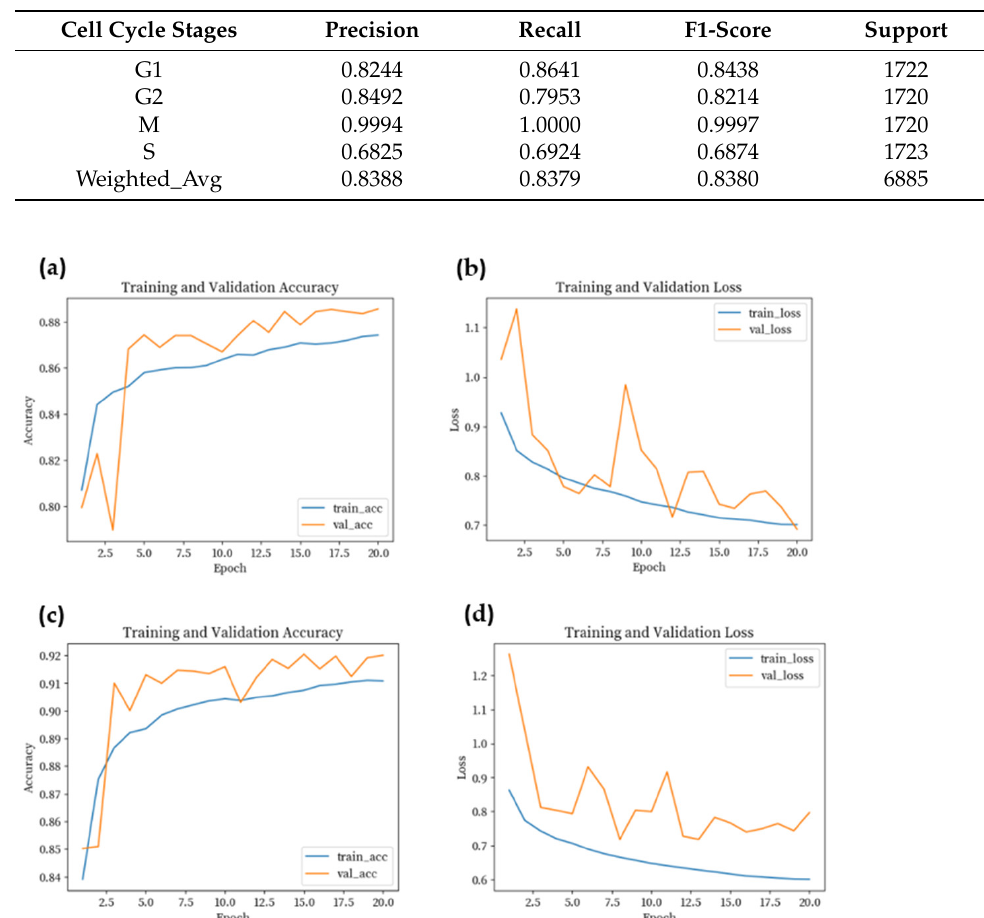
Figure 8. The ROC curves of classification. ( a ) Four-stage classification of original images; ( b ) four- stage classification of generated images. 4.3. Verification of Results with New Dataset In order to verify the effectiveness of our model, another cell cycle data set was used. Nagao et al. [13] collected fluorescence microscope images of different cell cycles contain- ing subcellular structures, such as the nucleus, the Golgi apparatus, and the microtubule cytoskeleton (HeLa dataset). The classification of different cycle stages could be carried out by extracting the characteristics of these subcellular structures. The data set contained only two categories, namely G2 and non-G2. The cell cycle images of the G2 phase were regarded as one class, and the images of the G1 phase and the S phase were regarded as one class. The images of the M phase were not in this data set. The numbers of images in the G2 class and the non-G2 class were each 922. The original images of the G2 class and the non-G2 class are shown in Figure 9. The WGAN-GP was used to generate images for the G2 class and the non-G2 class, and the generated images are shown in Figure 9. Although the original images of this data set were balanced, data augmentation was carried out on this data set to verify the effects of WGAN-GP. Each class used WGAN-GP to generate 10,000 images and used random under-sampling to obtain 9220 images. Then, the 9220 images were used for classification. The results of the classification for the origi- nal images and generated images are shown in Table 9.